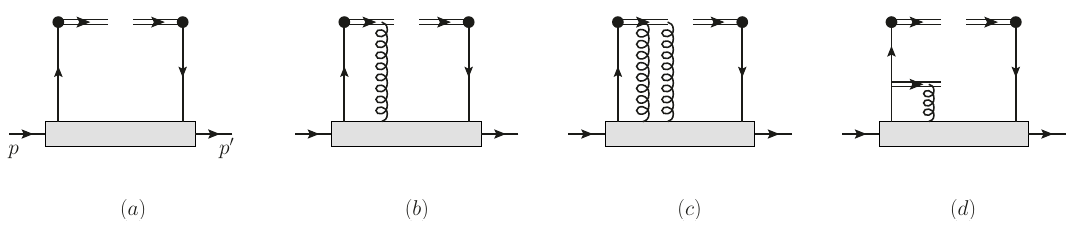
Figure 1 . The tree-level diagrams for quasi-GPDs. The double lines in the top of diagrams stand for gauge links along the z -direction. In (d) the double line in the middle stands for the gauge link along the n -direction(see the corresponding text after eq.